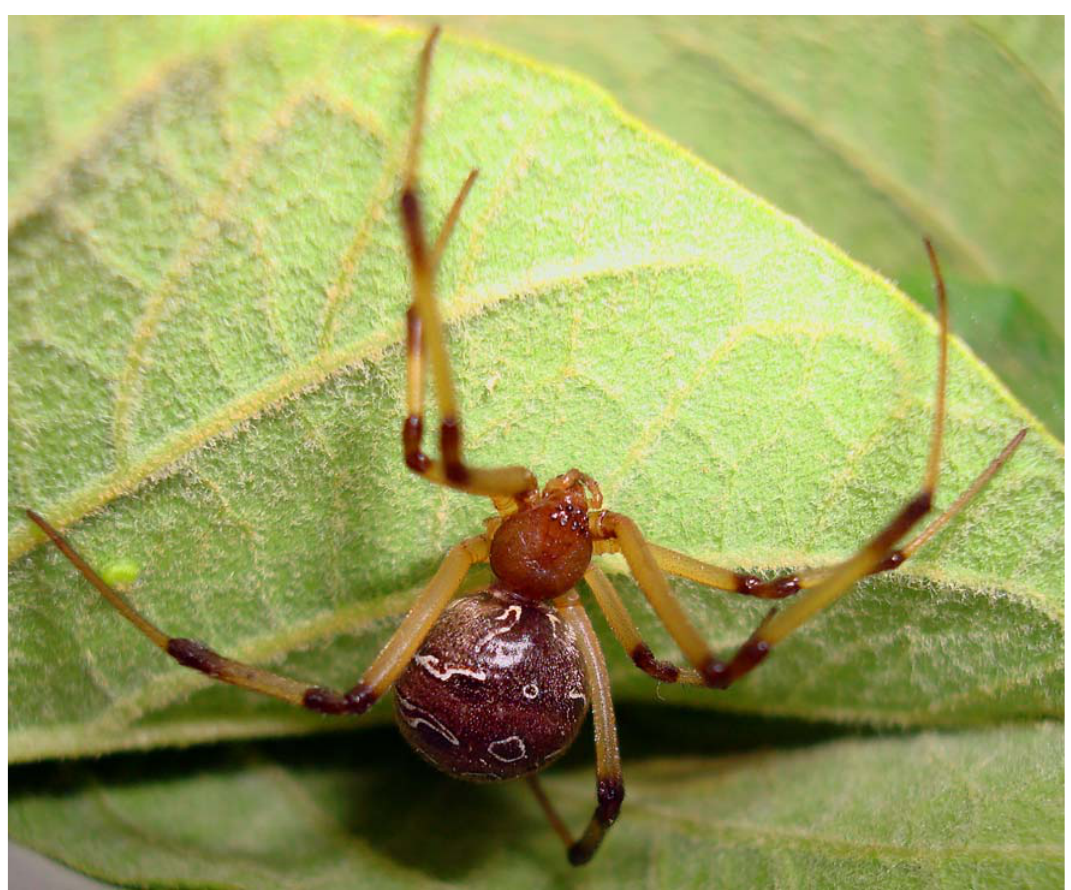
Figure 3. Latrodectus geometricus spider (brown